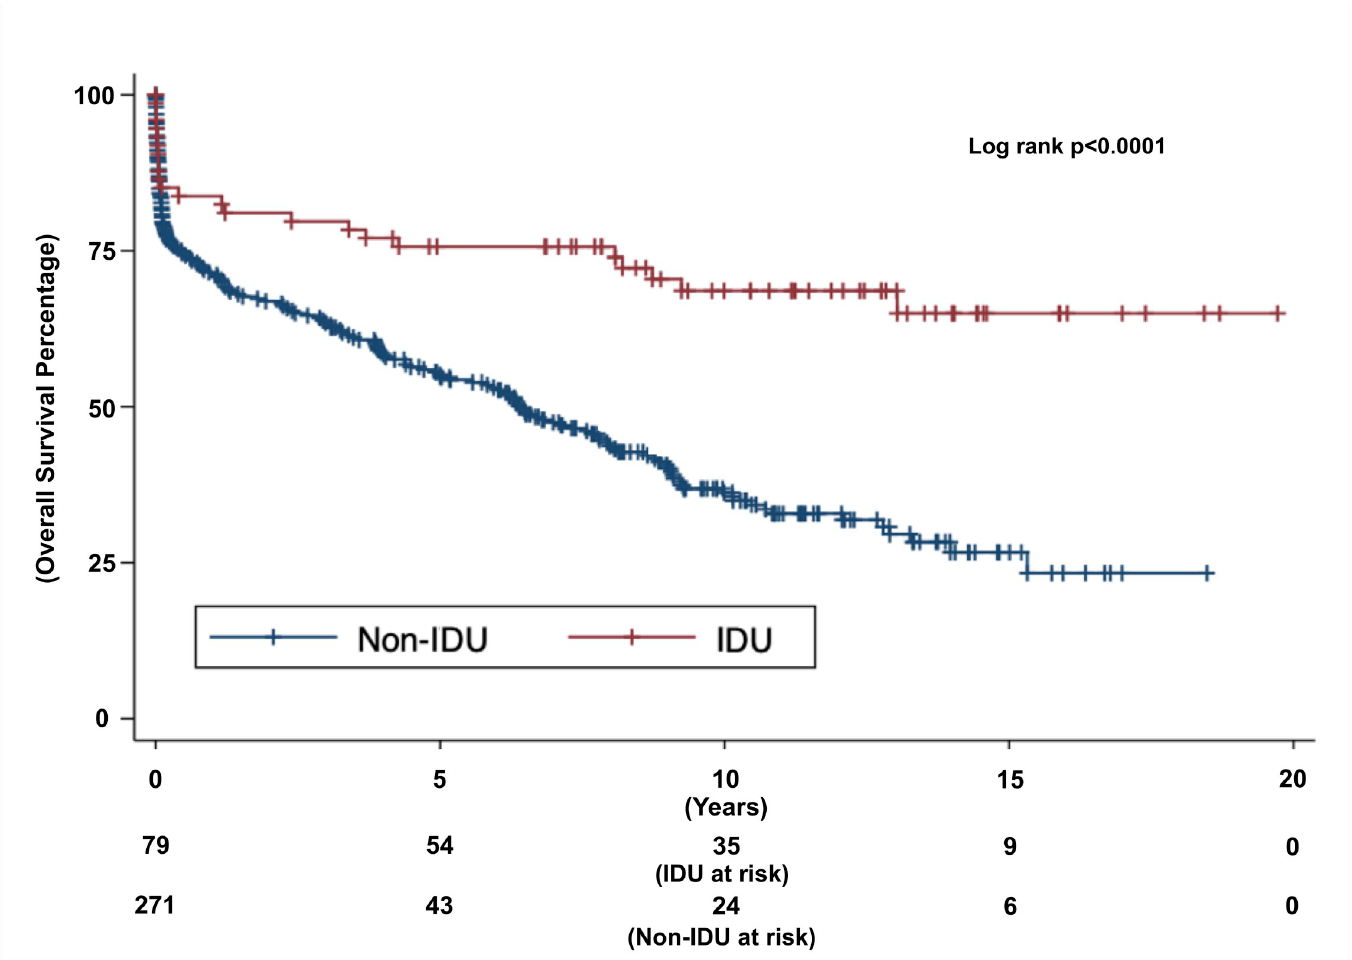
Fig 1. Injection drug use associated versus non-injection drug use associated Kaplan Meier survival curves. Light coloured line represents injection drug use associated populatuion and dark coloured line represents non-injection drug use associated populatuion. Y-axis represents overall survival in percentage. X-axis represents follow up length in years. Under the X-axis is the number of patients at risk in the IDU and non-IDU populations respectively. Censor bars indicate patient’s total follow up length without death.